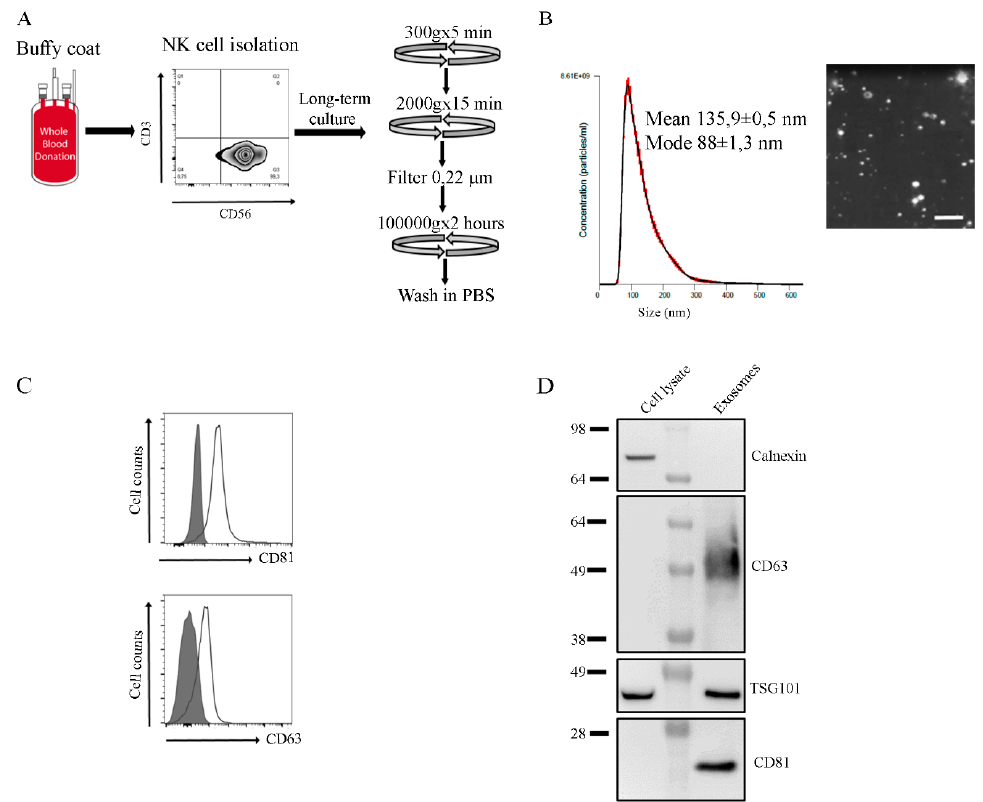
Figure 1. Characterization of exosomes released by human natural killer (NK) cells. ( A ) Flow chart for NK cell culture and NK exosome isolation. ( B ) Nano-particle size distribution curve and picture of NK-derived exosomes by nanotracking analysis (NTA). One out of 4 representative preparation of exosomes is shown. Mean and mode numbers are reported. Bar: 500 nm ( C ) Flow-cytometry analysis of CD81 and CD63 expression on beads-conjugated exosomes derived from NK cells. Filled grey profiles and black lines represent control isotype and samples stained with CD81 or CD63, respectively. ( D ) Western blot analysis of CD81 (23 kDa), CD63 (30-60 kDa), TSG101 (43 kDa), and Calnexin (90 kDa) expression on NK cell lysates compared to NK-derived